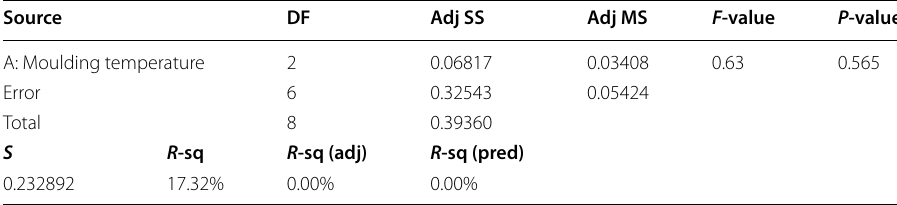
Table 5 One-way analysis of variance for the moulding temperature